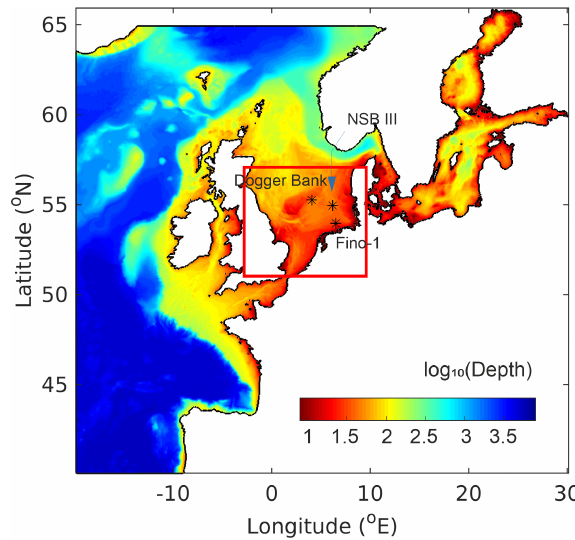
Figure 1. GCOAST model domain. The bathymetry (m) is shown on a logarithmic scale. The locations of the observations from the Poseidon cruise (Dogger Bank) and MARNET stations (NSB III and Fino-1) are indicated with asterisks. The red frame defines the area of the middle and southern North